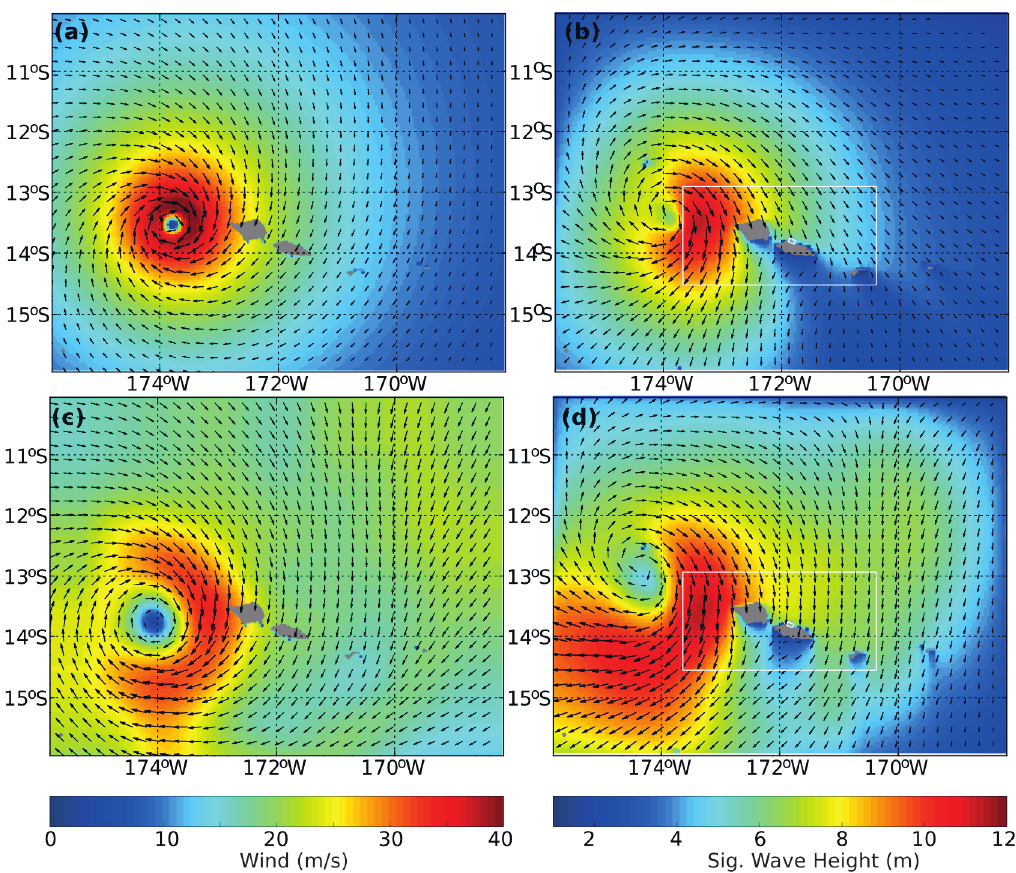
Figure 3. Example of Holland vortex winds ( a ) and simulated significant wave height and peak direction ( b ) during the historical TC Ofa (on 2 February 1990, 1200UTC). CFSR winds ( c ) and simulated waves ( d ) are included for comparison. The larger white box in ( b ) and ( d ) indicate the 1-km resolution nested SWAN model region, the smaller white box indicates the location and extents of the Apia